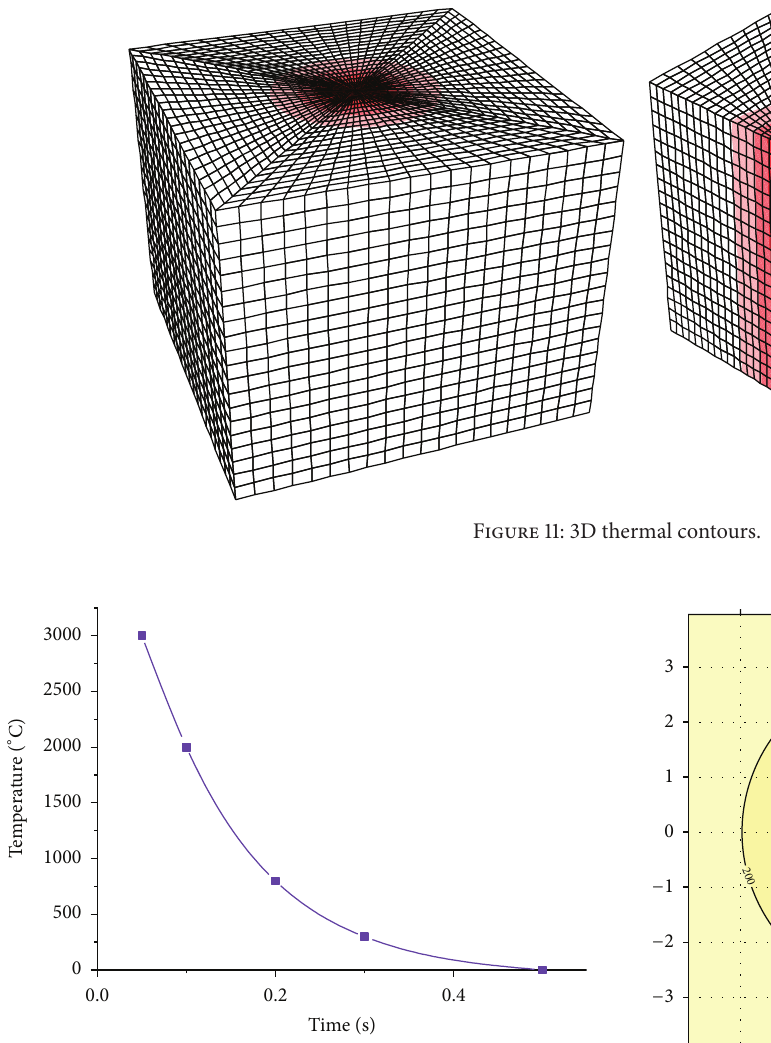
Figure 12: The temperature change curve.